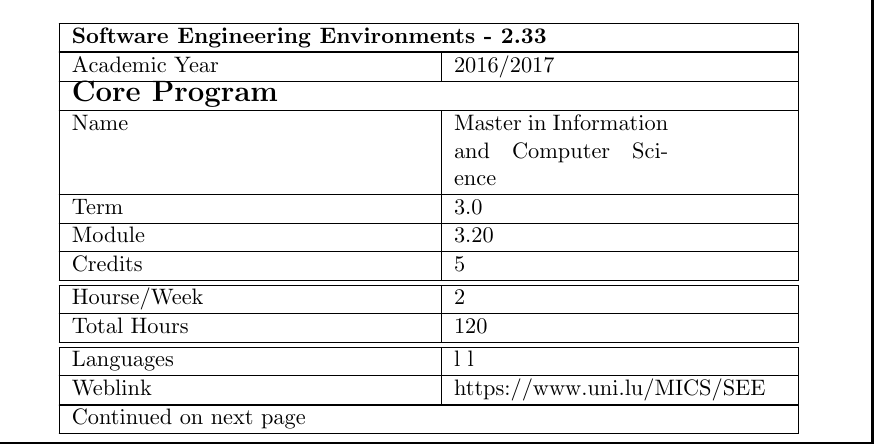
Table 3.1: Course Information